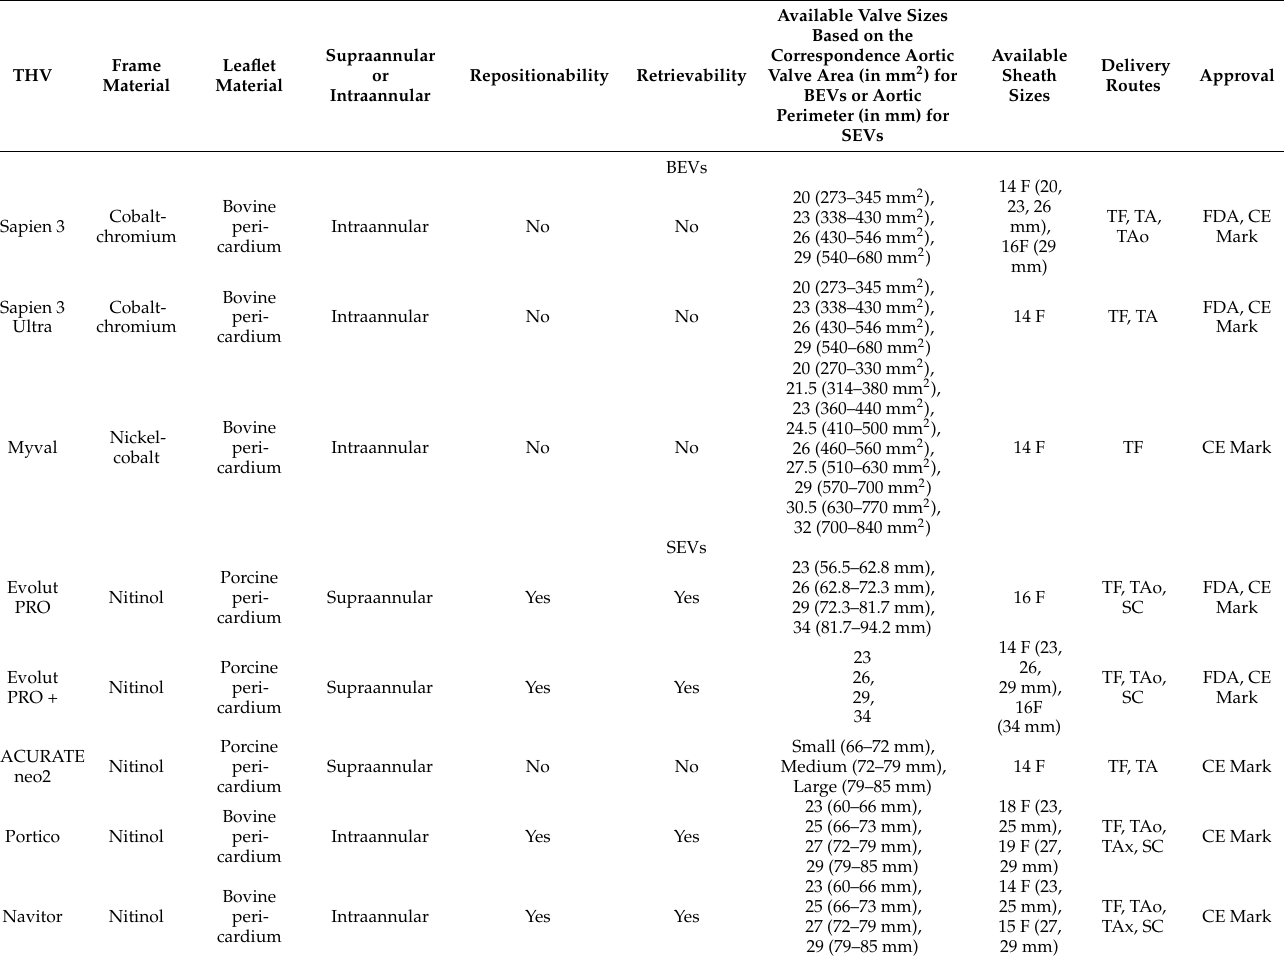
Table 1. Synopsis of the commercially available Transcatheter Heart Valves (THVs) with FDA and/or CE Mark